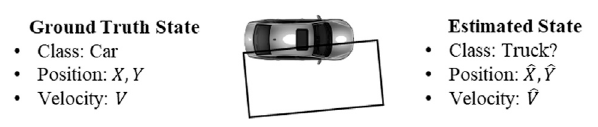
FIGURE 2 | Object detection.